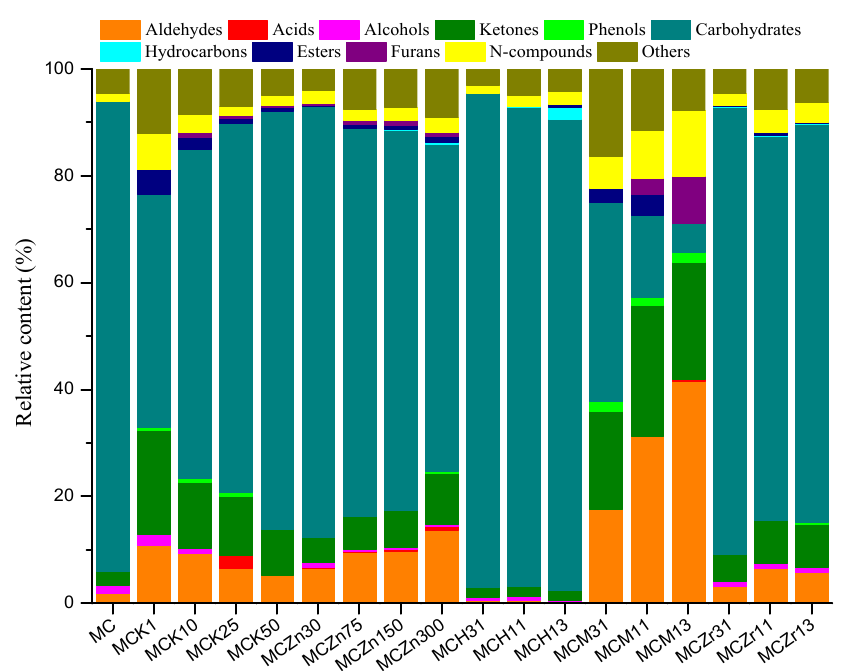
Figure 6. Distribution of bio-oil products from the catalytic pyrolysis of MC.